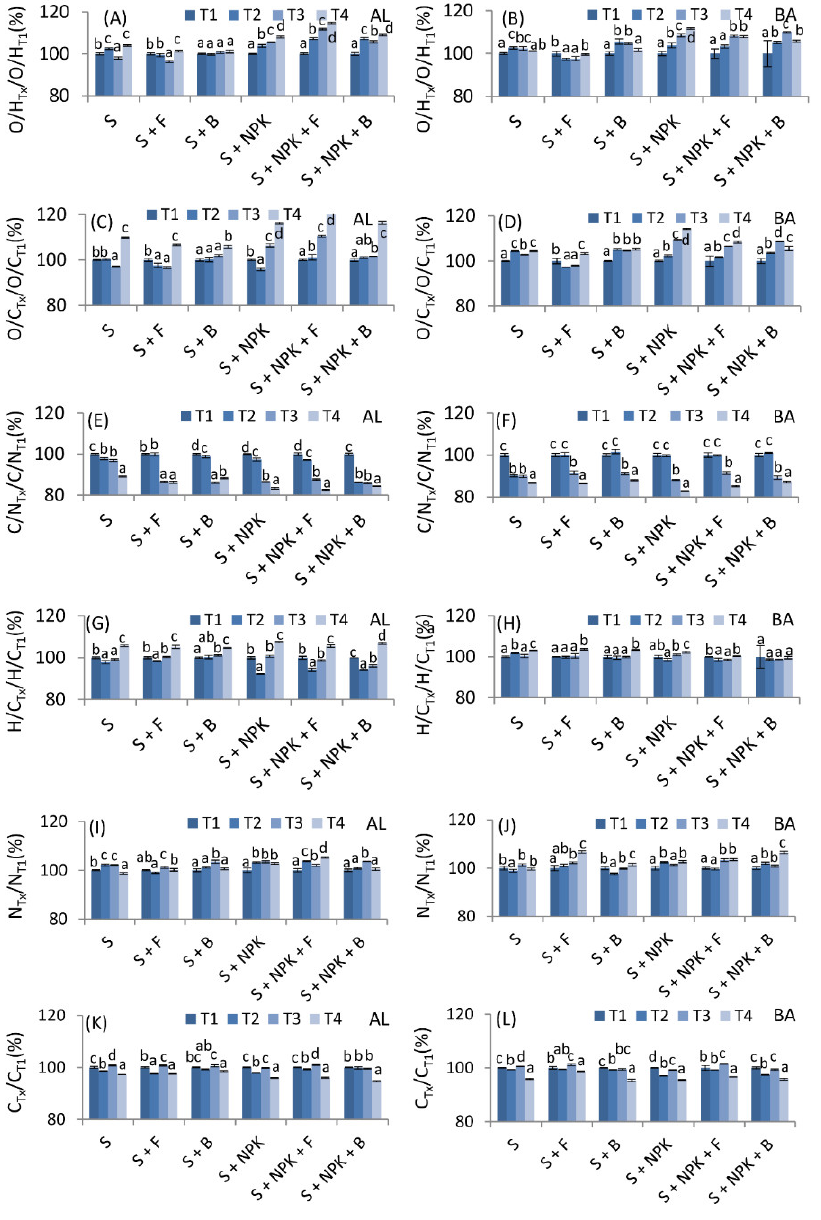
Figure 1. Changes in O/H ( A , B ), O/C ( C , D ), C/N ( E , F ), and H/C ( G , H ) atomic ratios, as well as the C ( I , J ) and N ( K , L ) content of HAs from Abruptic Luvisol (AL) and Brunic Arenosol (BA) soils, in the form of relative values with ± 5% thresholds, marked in gray lines. The values measured at T2, T3, and T4 were compared to the T1 (Control, 100%) values of the plot. S—soil without additives, S + F—soil with fungal strains, S + B—soil with bacterial strains, S + NPK—soil with NPK, S + NPK + F—soil with fungal strains and NPK, S + NPK + B—soil with bacterial strains and NPK. The figure shows mean values ± standard deviation. The same small letters mean no significant differences between the values at the level of significance α = 0.05 (one-way ANOVA variance analysis, Tukey’s HSD test).